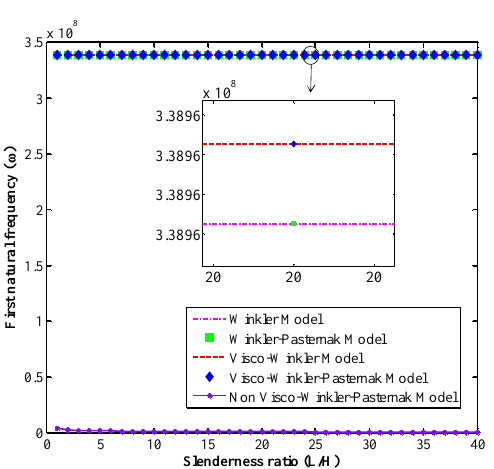
Fig. 7. The influence of material length scale